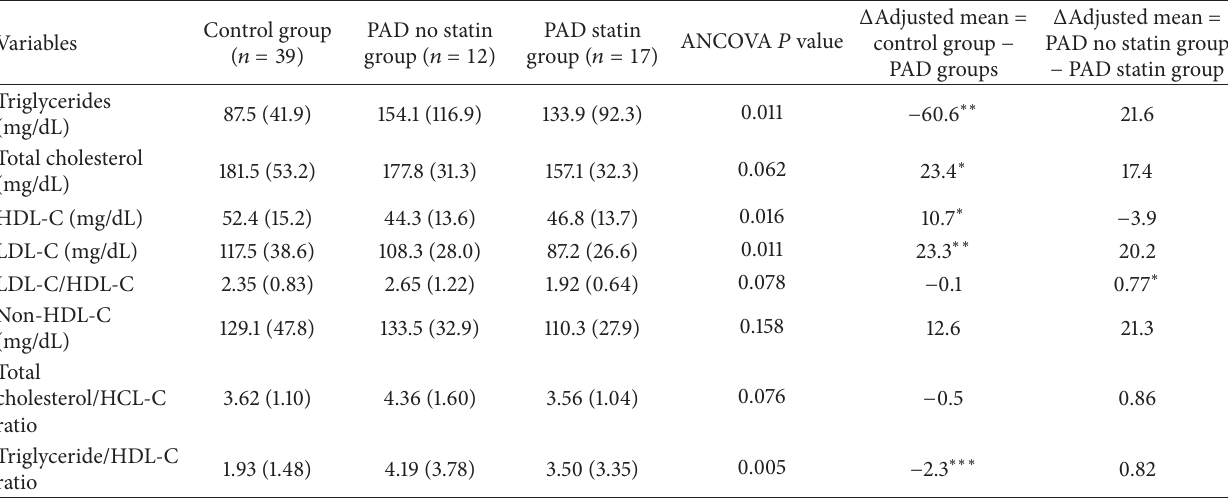
Table 2: Lipid measures of subjects with peripheral artery disease (PAD) and controls. Values are means (standard deviation). Variables